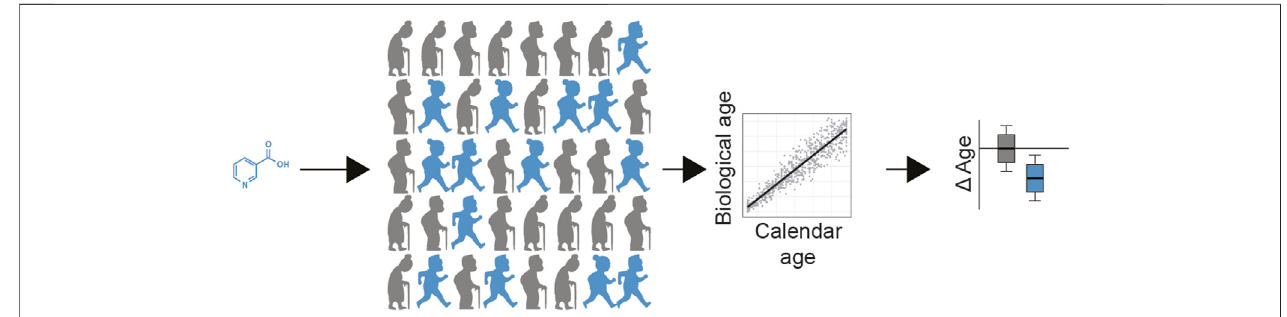
FIGURE 2 | Population level testing of longevity interventions. In this example, a safe nutraceutical can be given to participants (blue = receiving treatment, grey = receivingplacebo).Afteraprede fi nedperiodofadministration,individualsassesstheirbiologicalage,comparedtotheirchronologicalage,calculatingdeltaAge.Thiscan be used to determine if the drug has a statistical effect at decelerating aging at the population level. In addition, personal data of the participants (e.g., sex, genetics, lifestyle, age, genetics, microbiome) can be used to help decipher which sub populations bene fi t the most from the treatment (not shown).